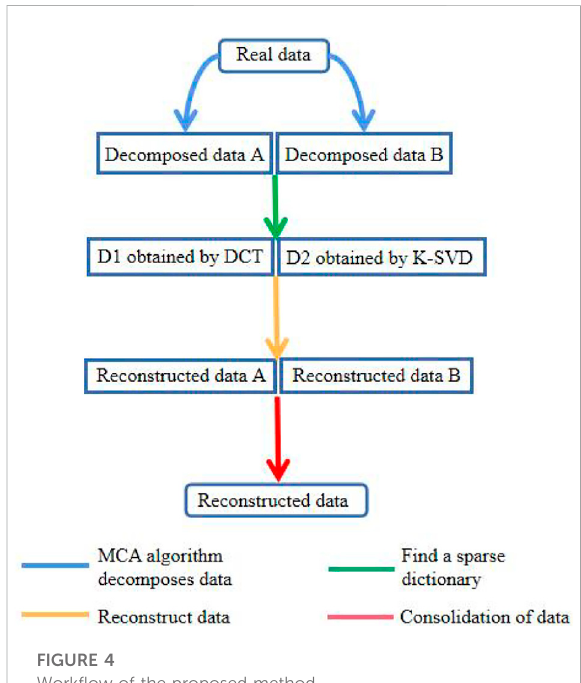
FIGURE 4 Work fl ow of the proposed method.